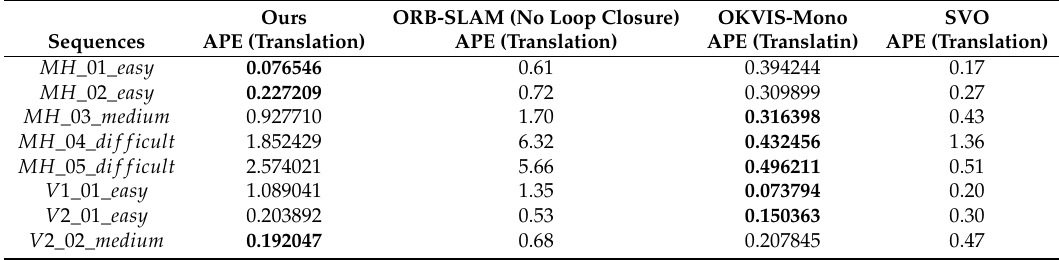
Table 1. Evaluation results of the evo tools on different algorithms. The table shows the error in the translation part of the APE in meter. Bold numbers indicate that the estimated trajectory is closer to the true value. The results of ORB-SLAM are for reference only and do not participate in comparison. Compare our algorithm to Oriented FAST and Rotated BRIEF-Simultaneous Localization and Mapping (ORB-SLAM) (no loop closure), Open Keyframe-based Visual–Inertial SLAM (OKVIS-mono), and semi-direct VO (SVO).